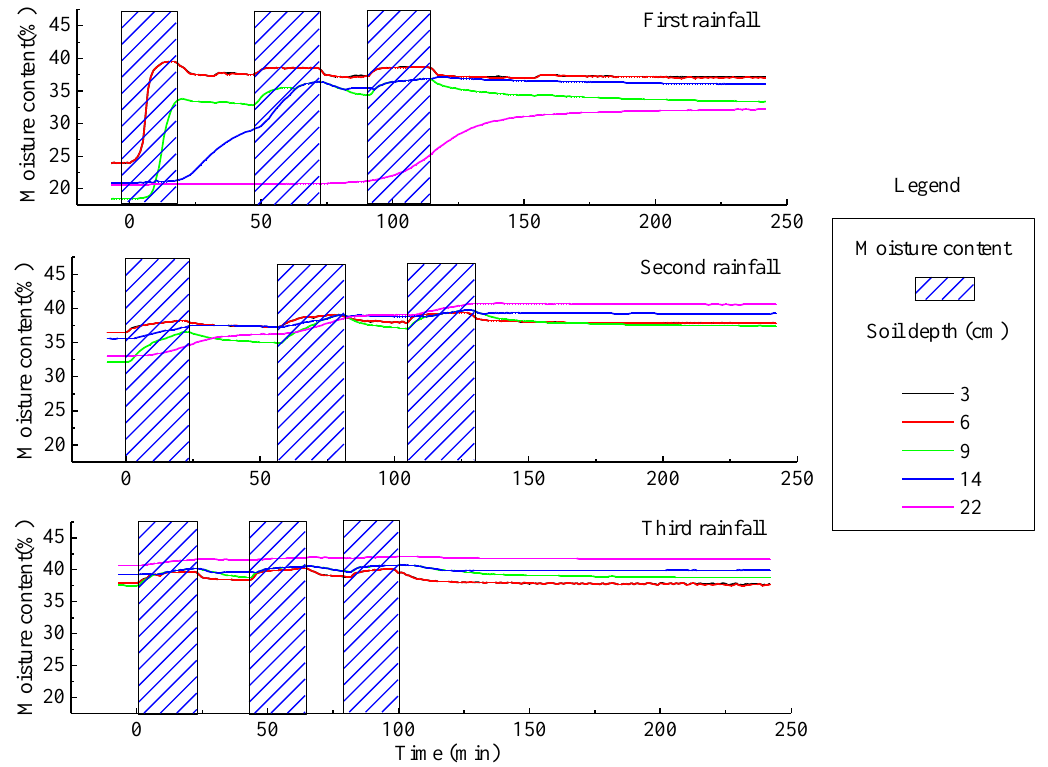
Figure 7. Dynamic change process of soil water content of the sand-covered slope at a rainfall density of 1.5 mm/min.